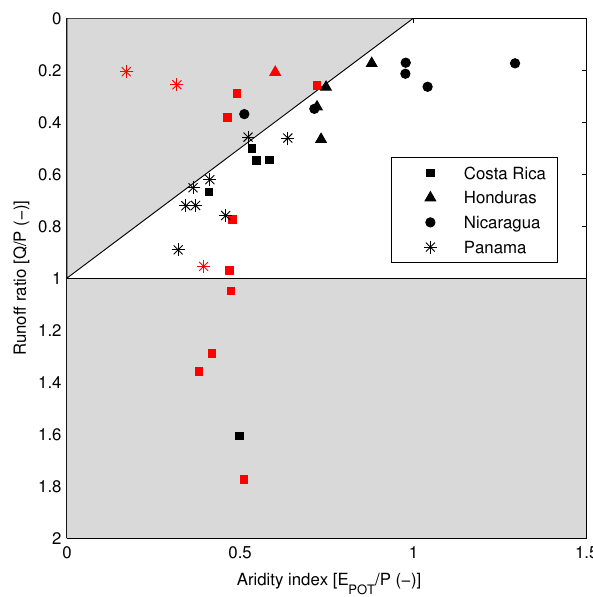
Figure 4. Budyko curve showing the relationship between the arid- ity index and the runoff ratio for periods with discharge data at each station in 1965–1994 (Fig. 2). Areas outside the theoretical limits of the Budyko curve (indicating inconsistent data) are marked in grey. Basins with a correlation between CPI (Eq. 1) and discharge for intermediate and high flows of less than 0.3, also indicating data inconsistencies, are plotted in